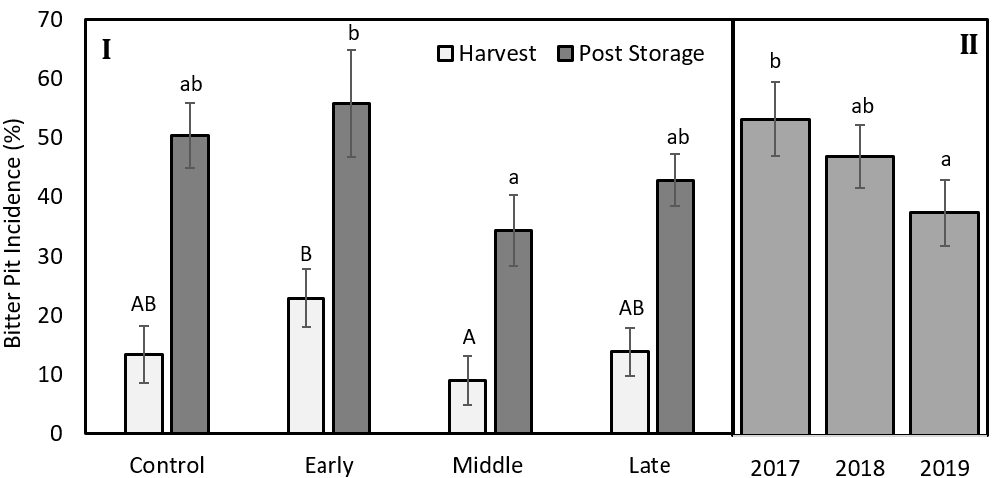
Figure 8. I . Percentage of total Honeycrisp fruit with bitter pit at harvest (light grey) and after three months of storage in regular atmosphere at 1 °C (dark grey) for trees where early, middle, and late summer water deficits were applied compared to a well-watered control. II . Bitter pit incidence after storage for fruit harvested in 2017, 2018, or 2019. Letters denote significant differences among treatments determined using a Fisher’s LSD test (α = 0.05).